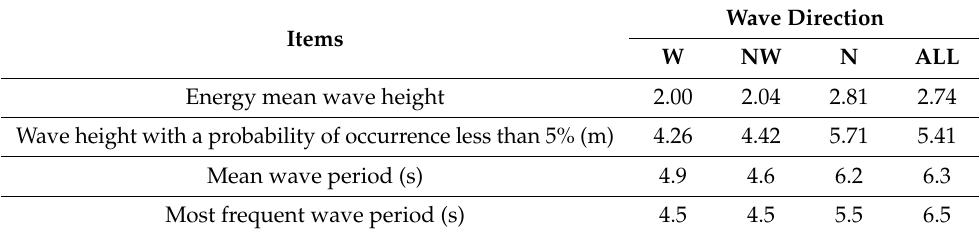
Wave Direction W NW ALL